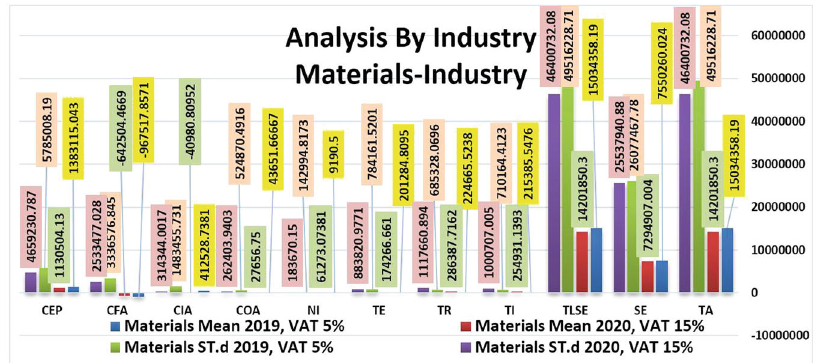
Fig. 4 Comparison of the fi nancial statements' key indicators in term of the average and standard deviation in Materials industry before and after rising VAT.